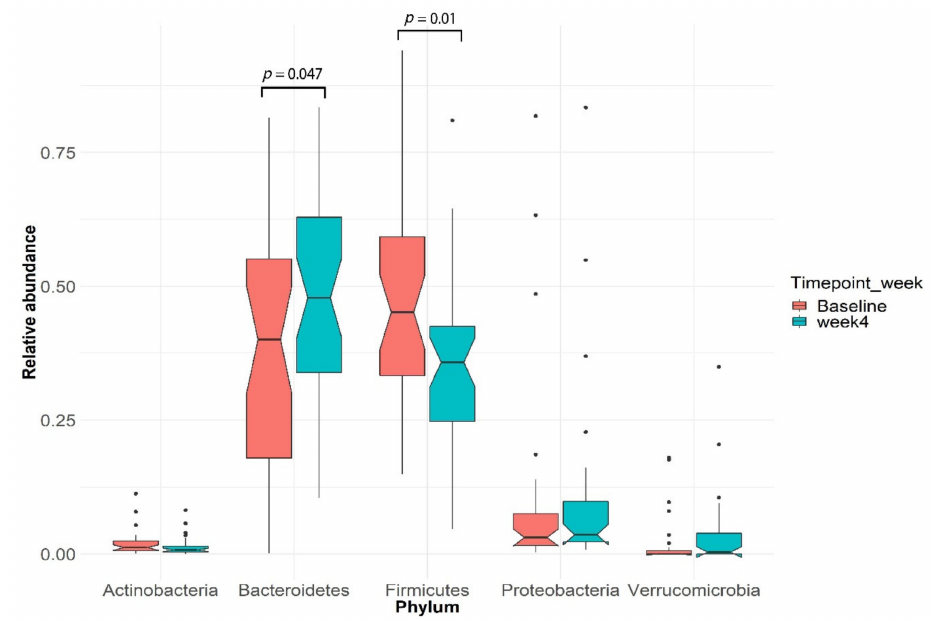
Figure 2. Firmicutes and Bacteroidetes are the dominant phyla in the subjects before and after very-low-calorie diet (VLCD) treatment. The figure shows boxplots of five typical human microbiota phyla. The boxes indicate the interquartile range (IQR) while the notch region shows the 95% confidence interval for the median and the whiskers extending from the boxes represent the distribution within 1.5 × IQR, with points beyond this range shown as outliers.